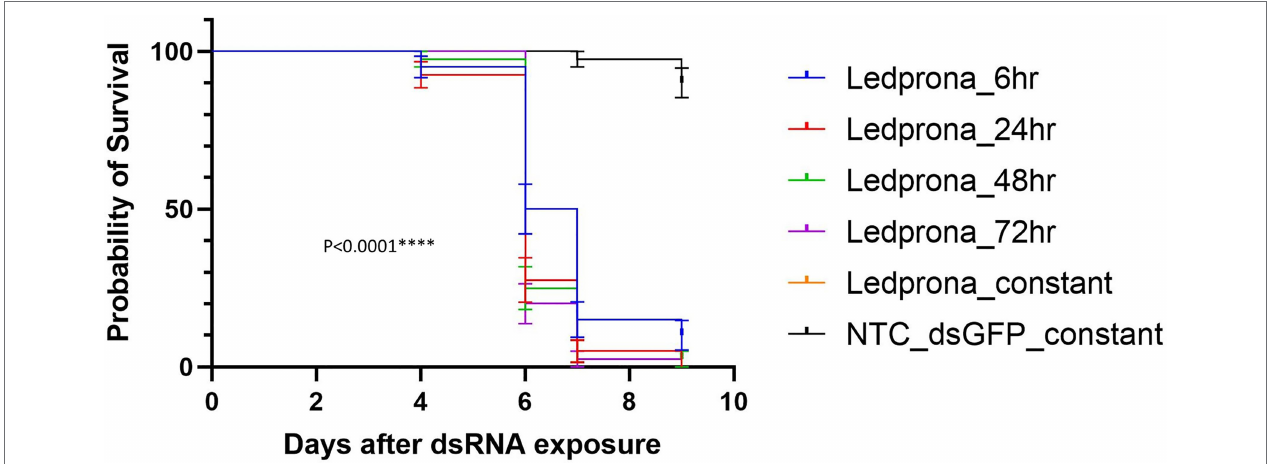
FIGURE 7 | Survival curves of second-instar CPB larvae after different times of Ledprona exposure [or dsGFP (control); N = 40]. Double-stranded RNA (dsRNA) applied at 255 × 10 − 5 g/L. Survival curves were plotted using the Kaplan–Meier method and compared using the log-rank Mantel–Cox test. Error bars denote 95% confidence interval. **** p < 0.0001.